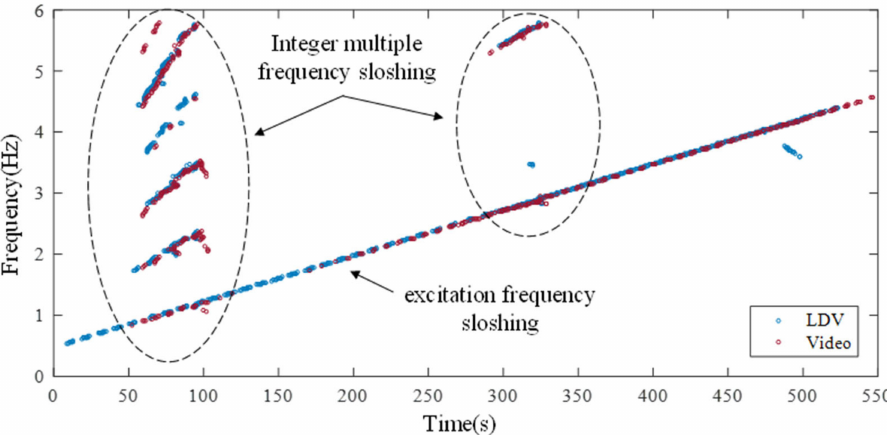
Figure 12. Spectrogram analysis of the first point over